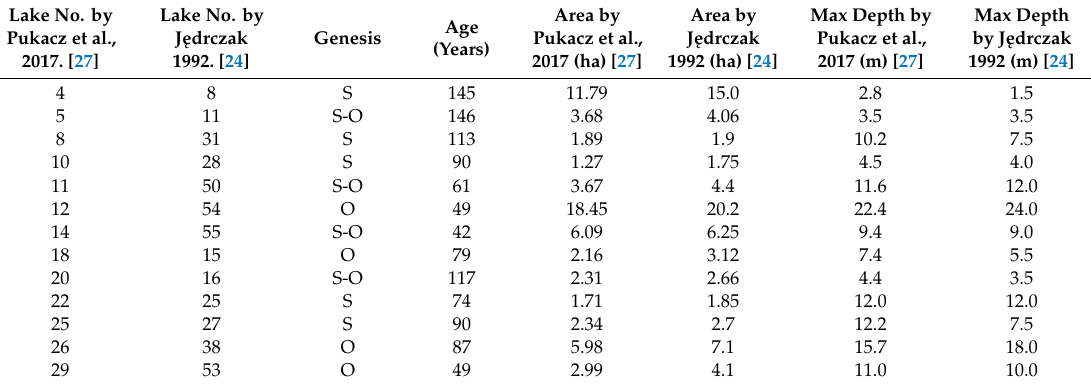
Table 1. Basic characteristics of the investigated pit lakes. Abbreviations: S—sink hole, O—open-cut, S-O—sink